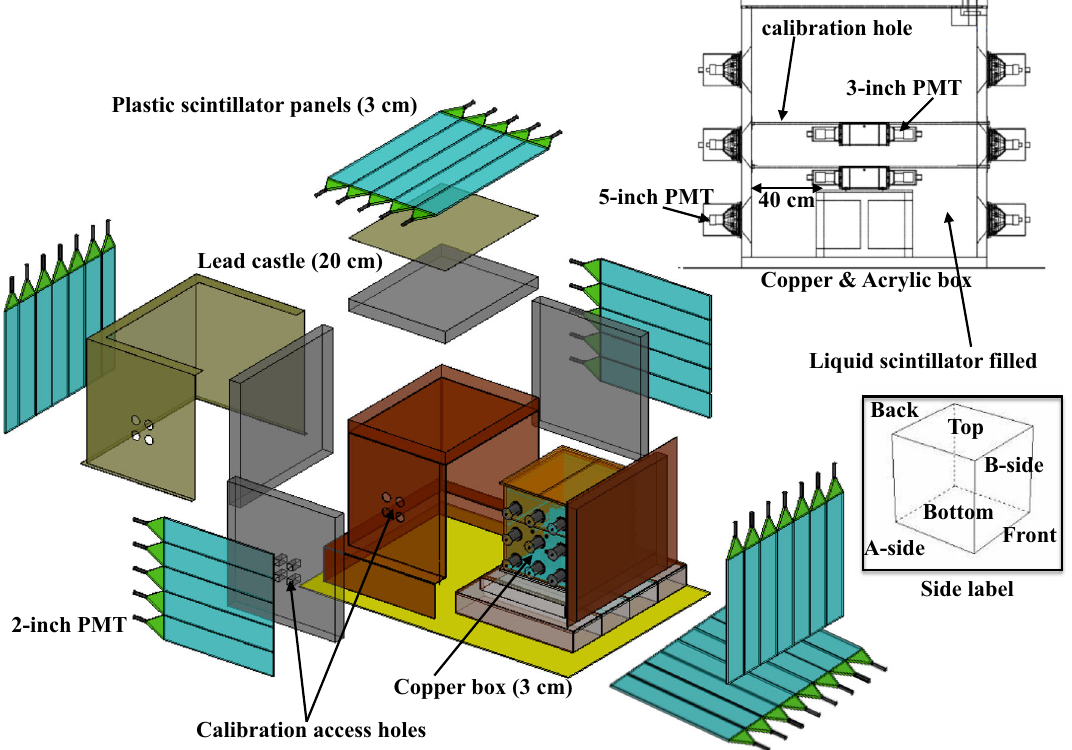
Fig. 1 COSINE shielding overview. From outside inward, muon pan- els (3cm thick, light blue), a lead brick castle (20cm thick on all sides, grey), a copper box (3cm thick), an acrylic box (1cm thick) and eight encapsulated crystal detectors immersed in the liquid scintillator